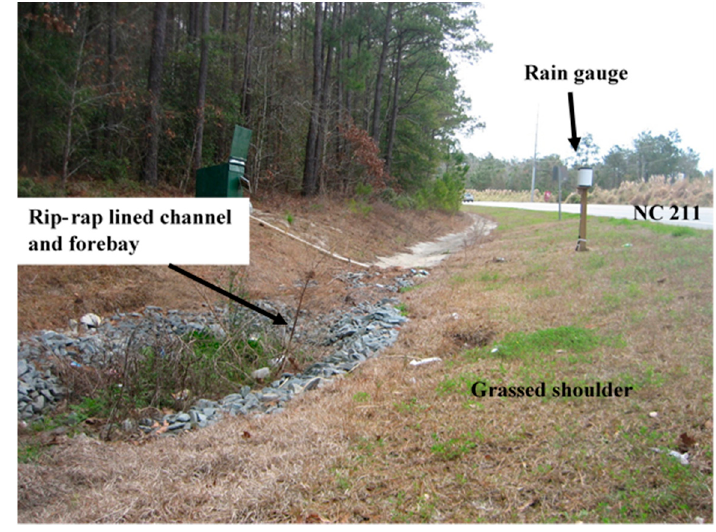
Figure 1. Watershed, grassed shoulder, and rip-rap channel and forebay [47].